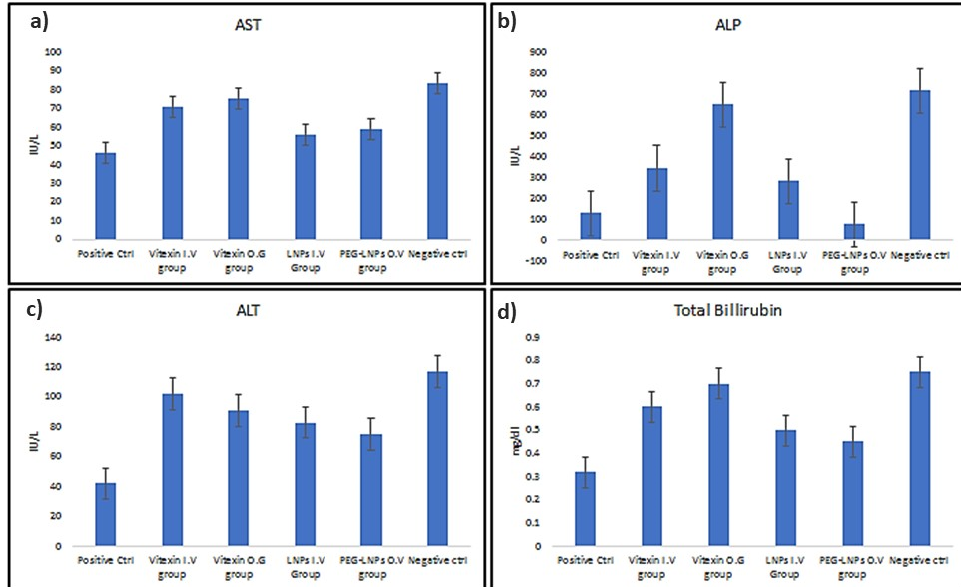
Figure 8. Serological indices of control versus diseased rats. Aspartate transaminase (AST) ( a ), Alkaline Phosphatase (ALP) ( b ), Alanine transaminase (ALT) ( c ). Total Bilirubin (TB) ( d ).